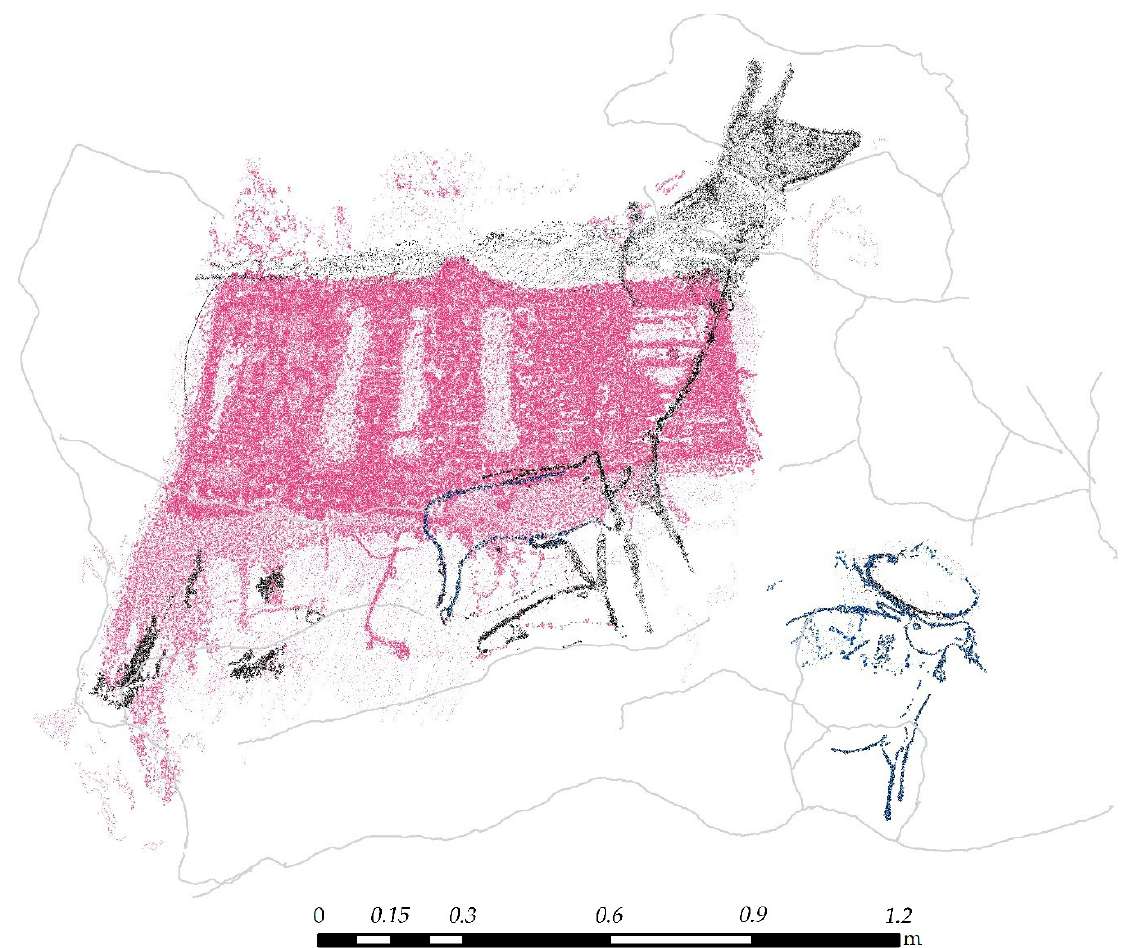
Figure 11. New tracing obtained by isolating pigment classes obtained after hyperspectral classification.